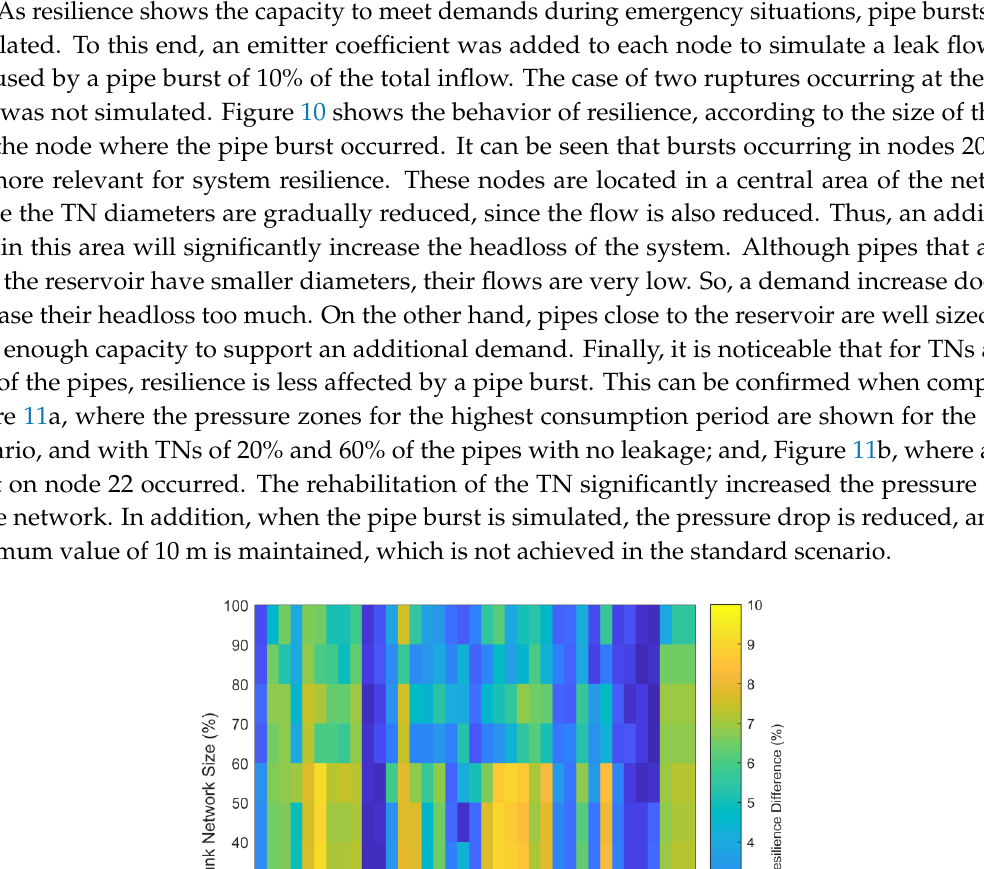
Figure 9. Resilience for a 24 h period in the Fossolo network.